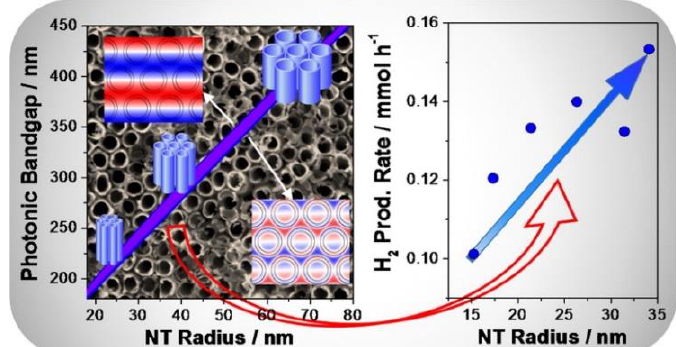
Figure 6. Dependence of the photonic band gap ( Left ) and H 2 production rate ( Right ) from the nanotubes inner radius. Reprinted with permission from [91]. Copyright © 2016 American Chemical Society.